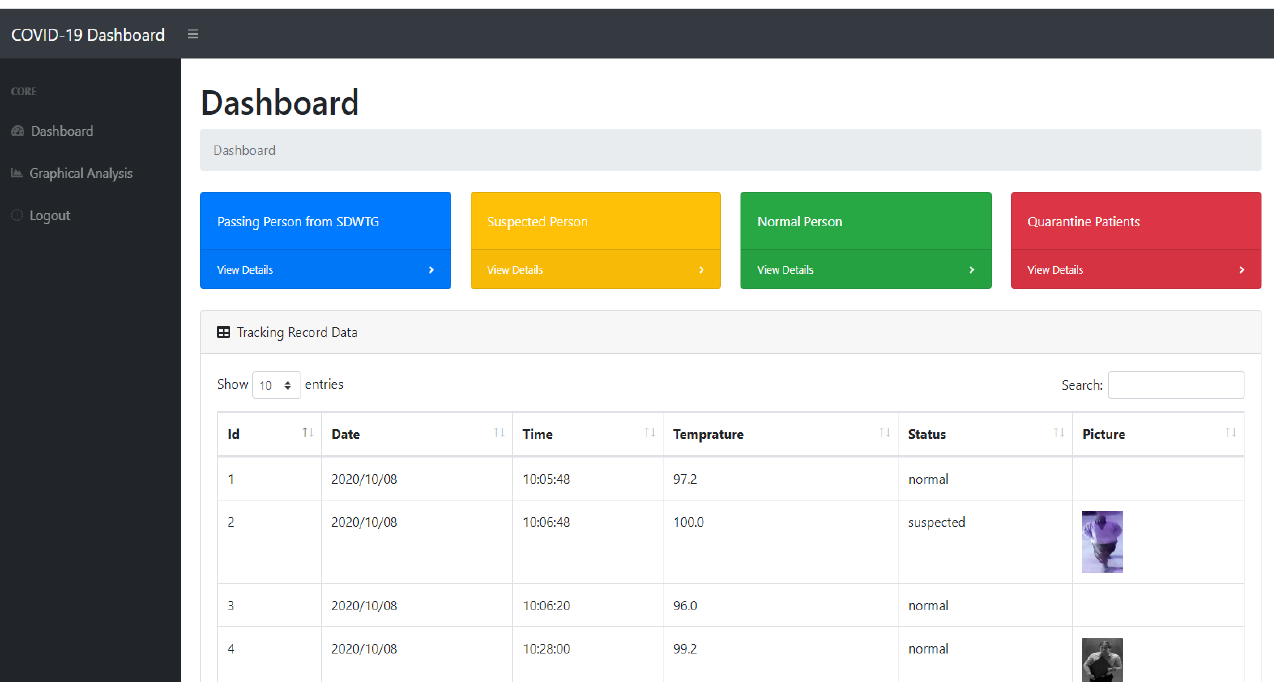
Figure 22. Smart Screening and Disinfection Walkthrough Gate (SSDWG) stored information about